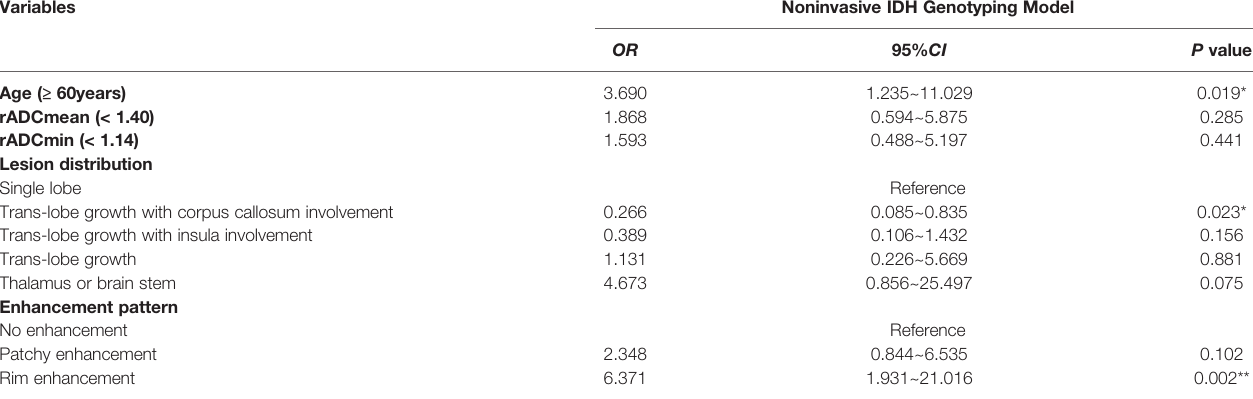
TABLE 7 | Multivariate logistic regression analysis of IDH status of